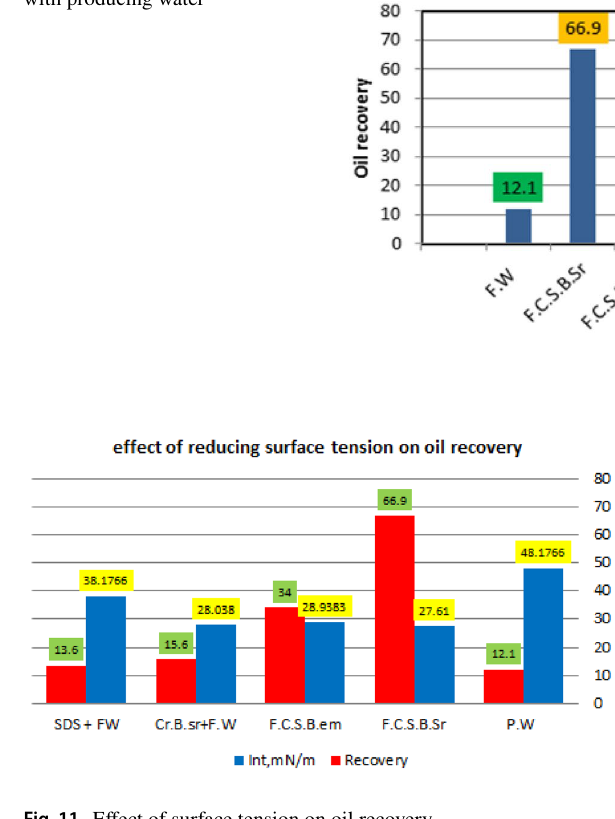
Fig. 10 a Oil recovery with different liquids. b Oil recovery by the F.C.S.B.Sr. after treated with producing water